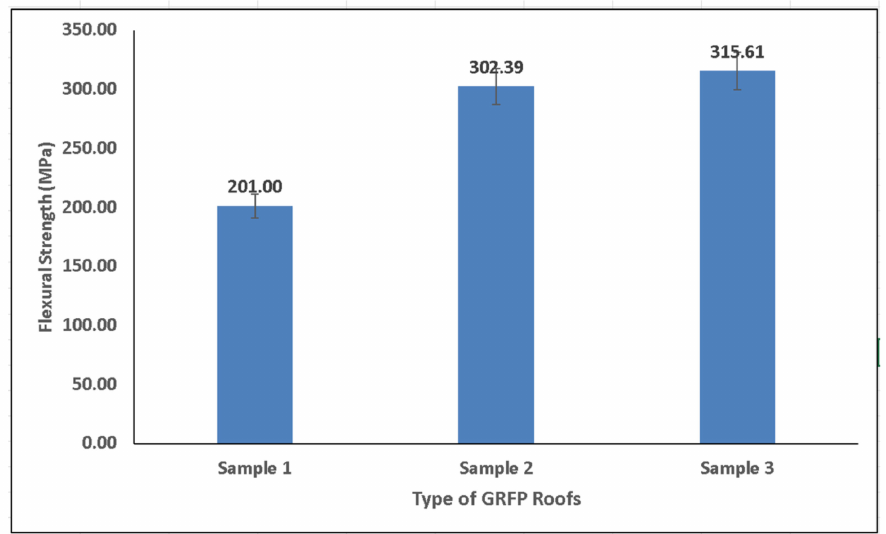
Figure 7. Flexural strength of GFRP composite